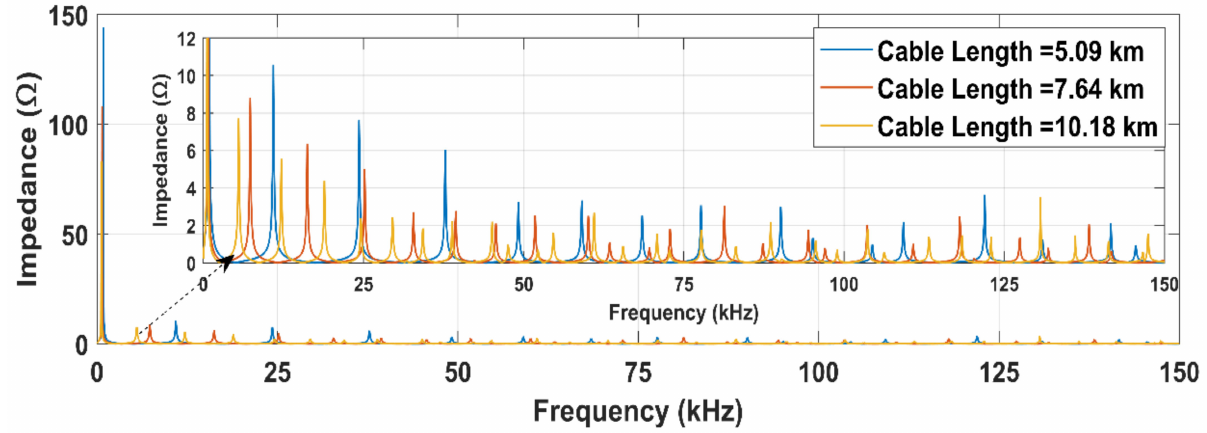
Figure 4. Frequency response at different cable